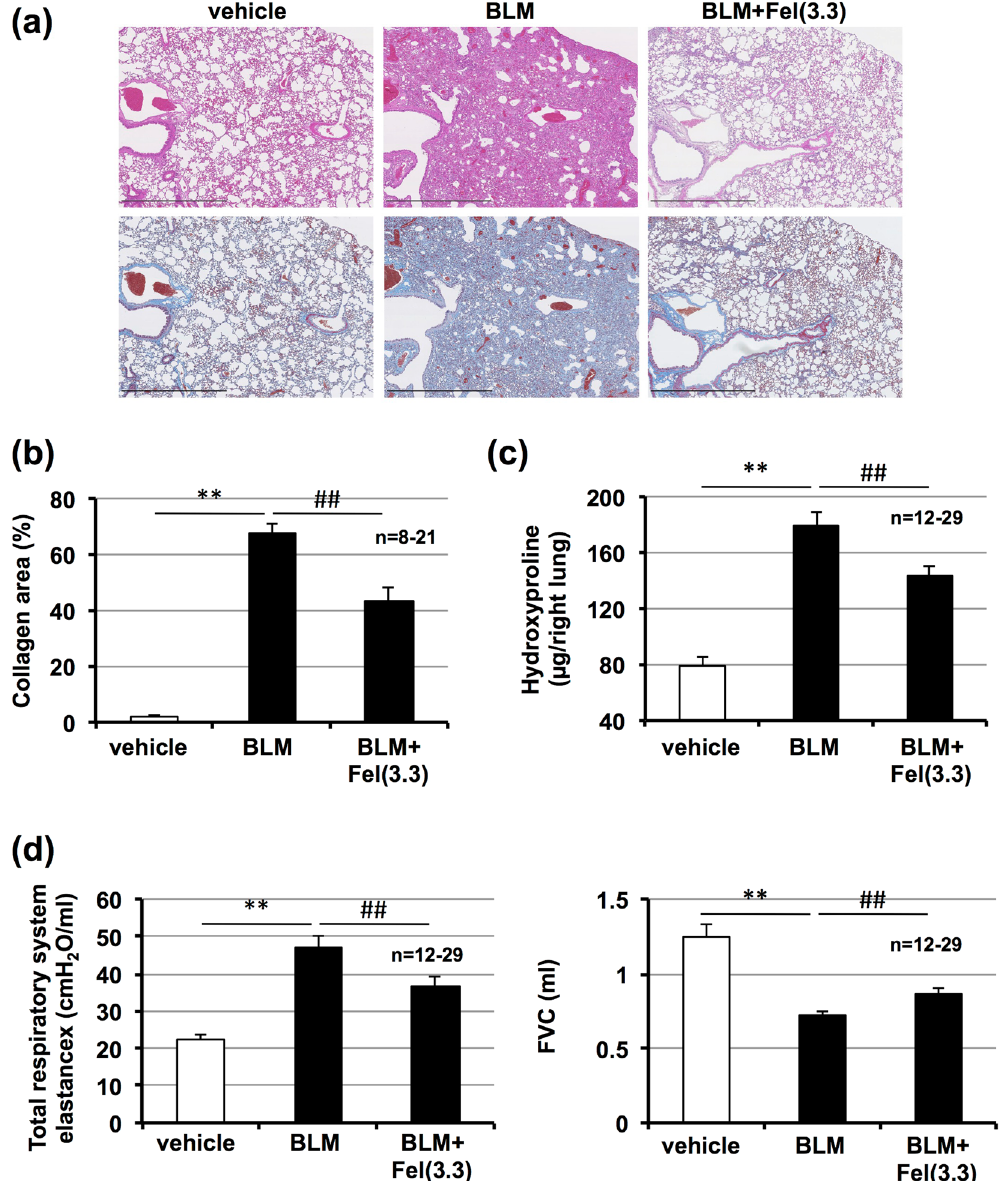
Figure 3. Effect of felodipine on pre-developed pulmonary fibrosis. Mice were intratracheally administered with bleomycin (BLM, 1 mg/kg) or vehicle once only on day 0. Mice were intratracheally administered indicated doses (mg/kg) of felodipine (Fel) once daily for 10 days (from day 10–19). Sections of pulmonary tissue were prepared on day 21 (48 h after final felodipine administration) and subjected to histopathological examination including H&E staining (upper images) and Masson’s trichrome staining (lower images). Scale bar = 1.0 mm ( a ). Percentage of collagen-positive area was determined based on images of Masson’s trichrome staining ( b ). Pulmonary hydroxyproline level was determined on day 21 ( c ). Total respiratory system elastance and FVC were measured on day 21 ( d ). Values represent mean ± S.E.M. * * or ## P < 0 . 01 ; # P < 0 . 05 . ( * vs vehicle, # vs